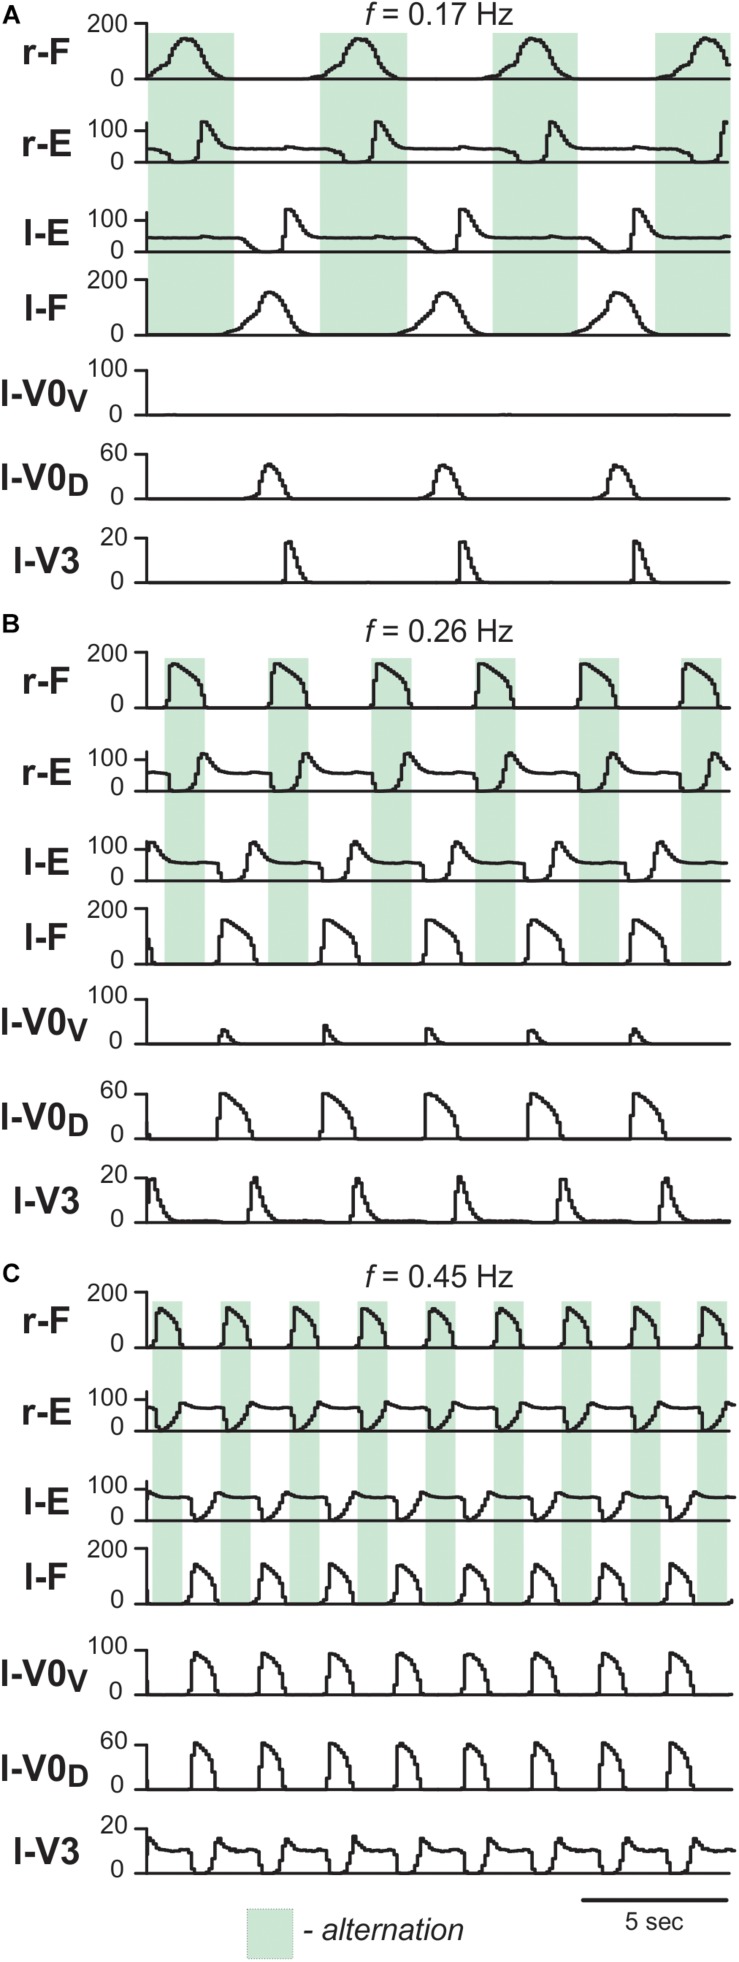
Model performance under normal conditions. Integrated population activities of flexor (F) and extensor (E) rhythm generator centers and left commissural interneurons are shown at low (A; α = 0.01), medium (B; α = 0.03), and high excitation levels (C; α = 0.09). Activities of populations in this and following figures are shown as average histograms of neuron activity [spikes/(N × s), where N is a number of neurons in population; bin = 100 ms]. Shaded green areas show intervals of right flexor activities. r-: right; l-: left.